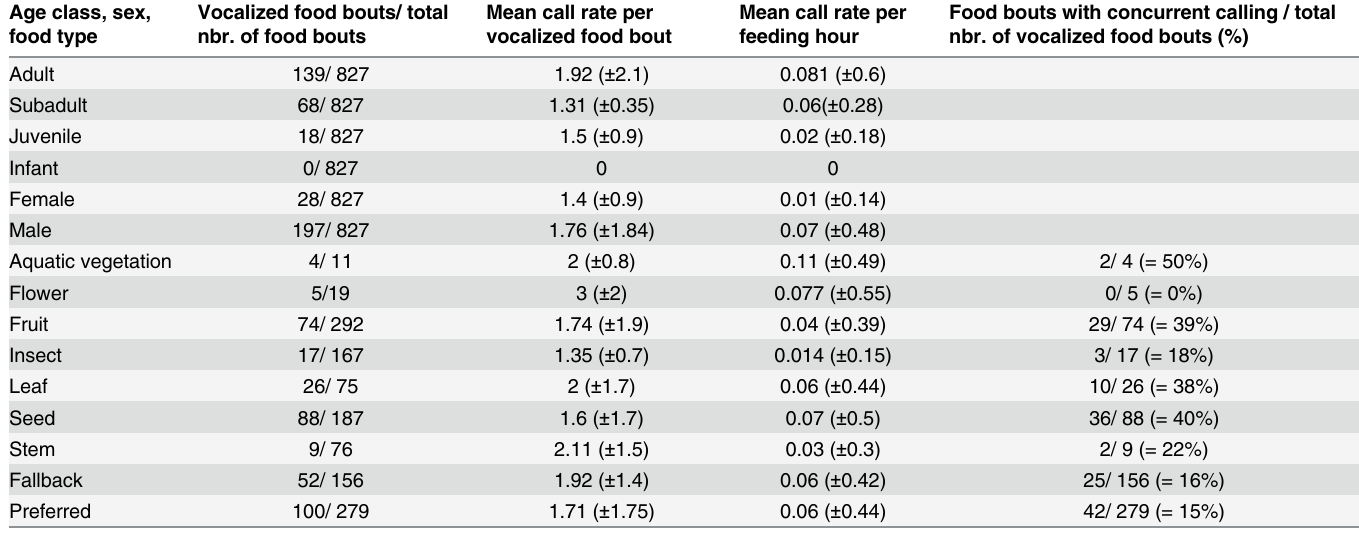
Table 3. Overview of descriptive